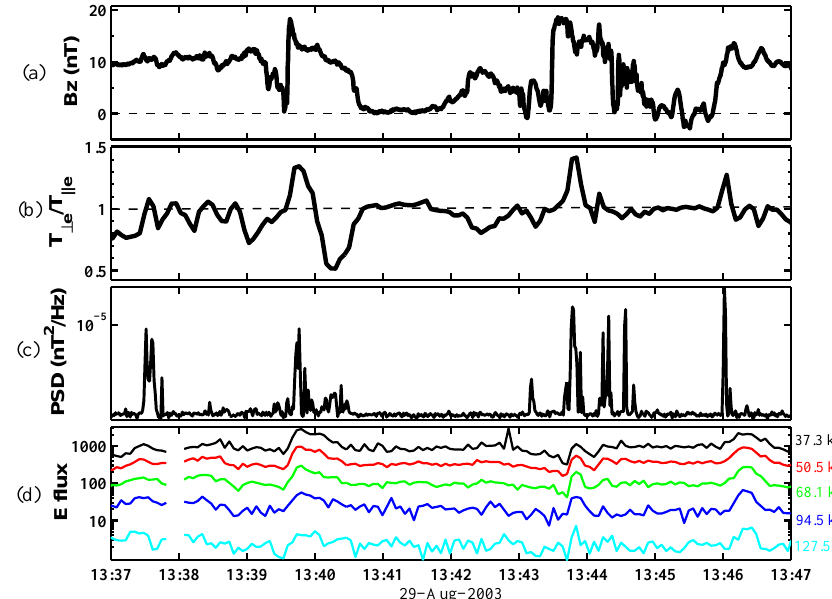
Fig. 7. (a) The Z-component of magnetic field; (b) ratios between the perpendicular and parallel electron temperatures, i.e. electron anisotropy; (c) total power spectrum density of magnetic field from 50Hz to 250Hz, i.e. power spectrum density of whistler waves; (d) the differential fluxes of energetic electrons (1/(cm 2 strskeV)).